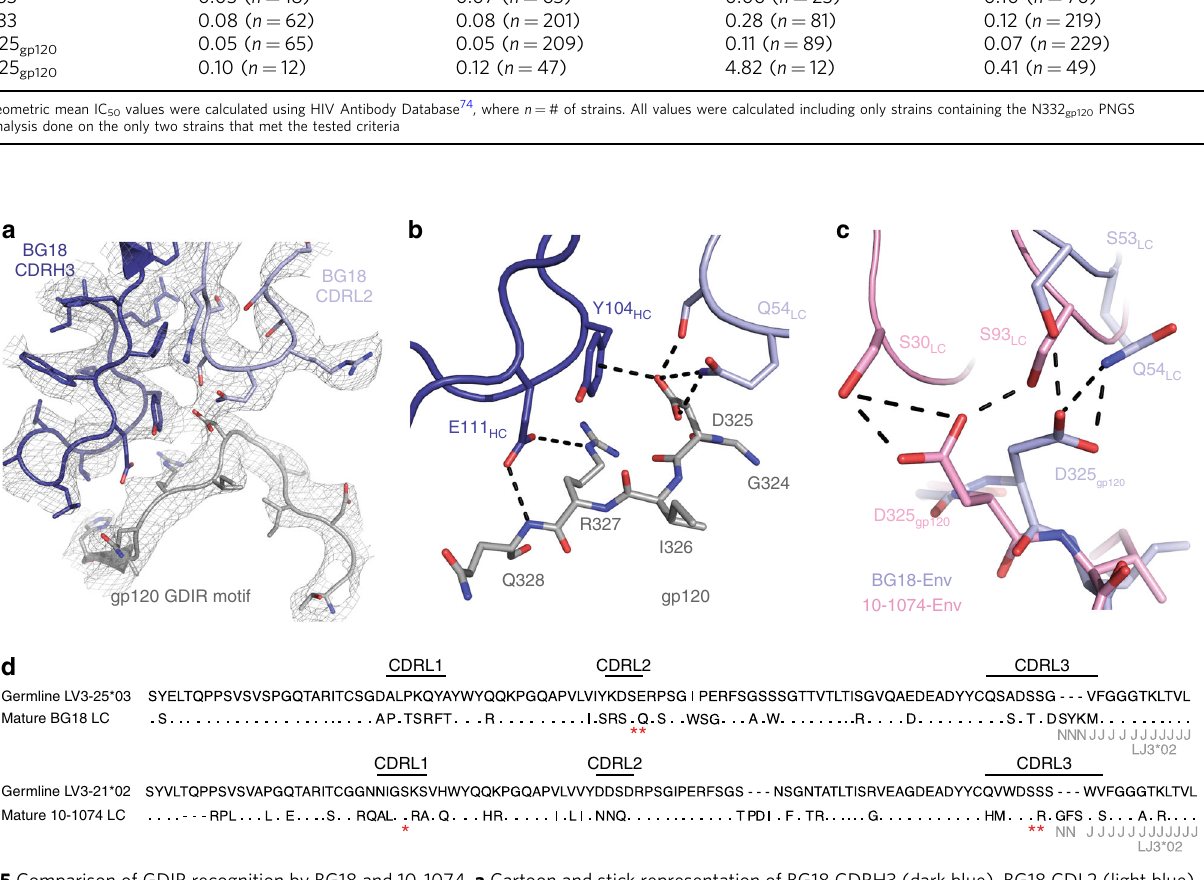
Fig. 5 Comparison of GDIR recognition by BG18 and 10-1074. a Cartoon and stick representation of BG18 CDRH3 (dark blue), BG18 CDL2 (light blue), and gp120 (gray; residues 318-330). Electron density contoured at 1 σ from 2 F obs − F calc fi nal re fi ned electron density map with − 100 Å 2 B-sharpening is shown (gray mesh). b BG18 interactions with the gp120 GDIR motif (G324g p120 -D325g p120 -I326g p120 -R327g p120 ) at the base of the V3-loop. In common with the PGT121-like bNAbs, CDRH3 E111 HC forms a potential salt bridge with R327 gp120 , while CDRH3 Y104 HC stacks against D325 gp120. In addition,